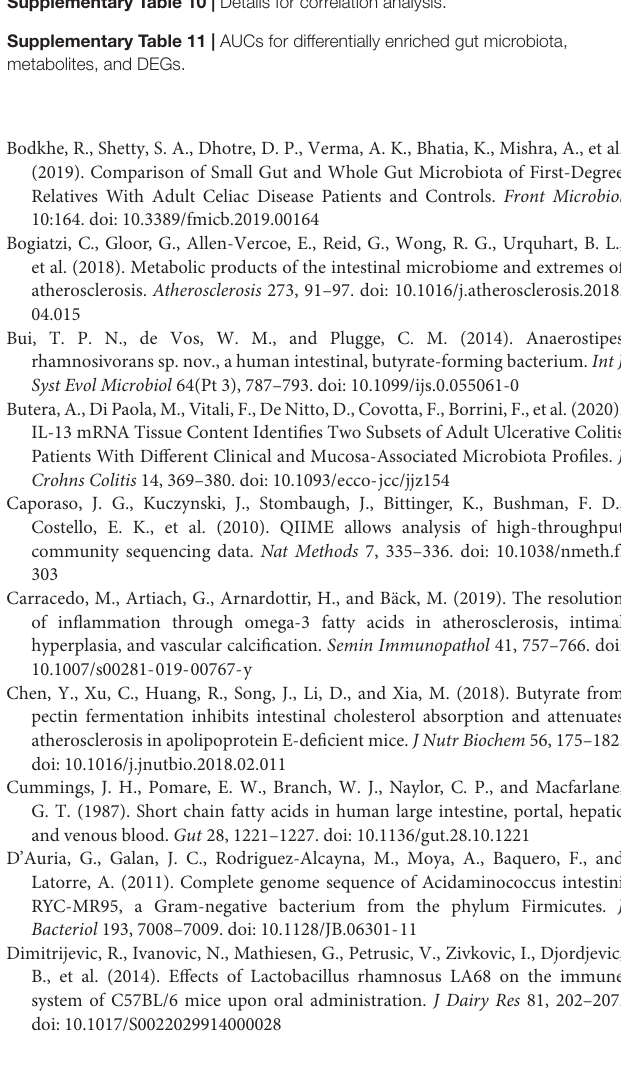
Supplementary Table 8 | Functional enrichment analysis for DEGs. Supplementary Table 9 | Enrichment analysis on the DEGs using the Reactome database. Supplementary Table 10 | Details for correlation